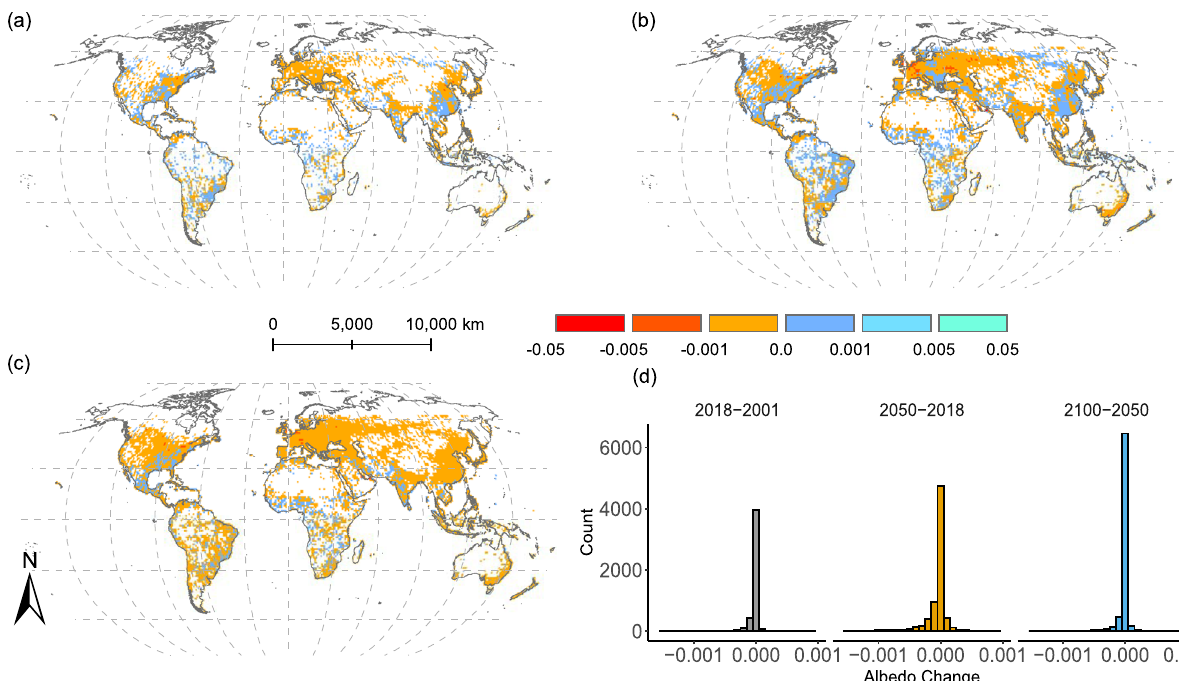
Fig. 1 Global changes in land surface albedo due to urbanization. a Changes in 2018 relative to 2001, b changes in 2050 relative to 2018, c changes in 2100 relative to 2050, and d the histogram showing the full distribution of the grid-level albedo changes. b , c are albedo changes under the SSP2-4.5 scenario. The albedo changes under SSP1-2.6 and SSP5-8.5 scenarios are provided in Supplementary Fig. 1 and show similar patterns as under